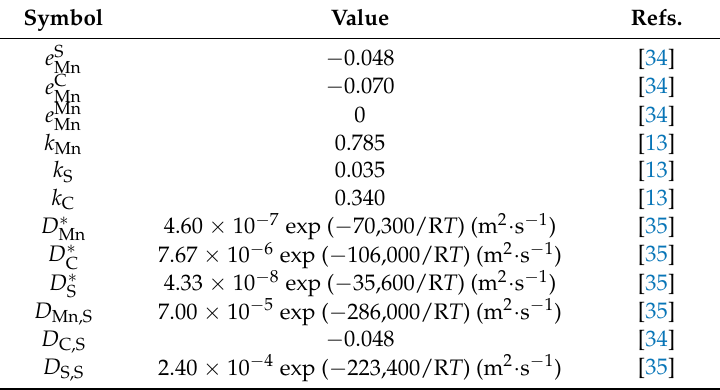
Table A2. Coefficients of solutal interaction and